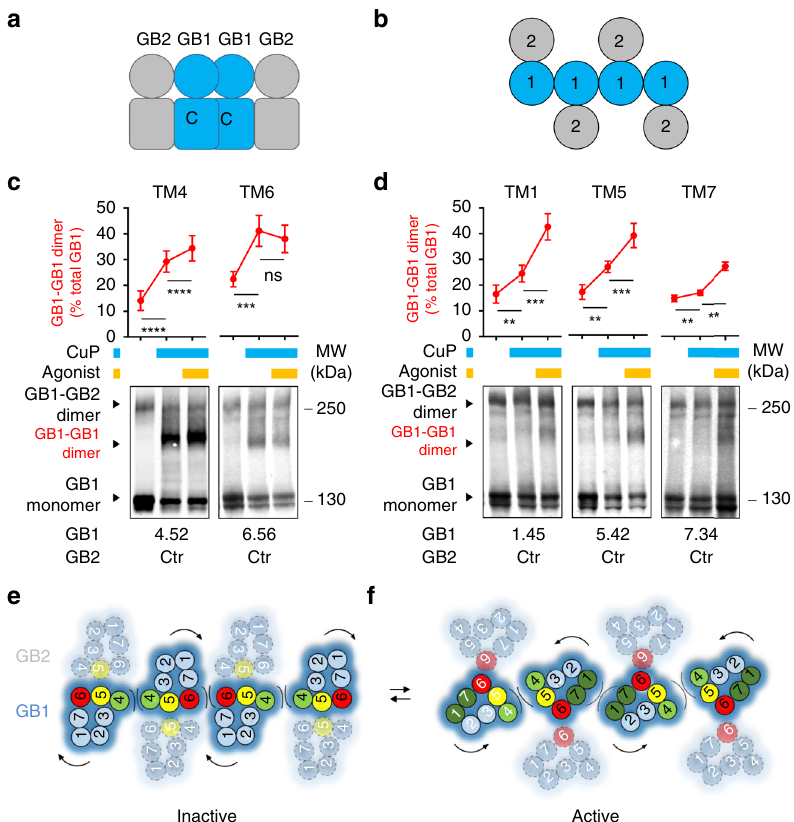
Fig. 6 Interactions between GB1 7TMs in GABA B oligomers during activation. a , b Schematic representation of a GABA B oligomer in lateral ( a ) and top view ( b ). c , d Blots showing cross-linking of cell surface SNAP-GB1 subunits containing a single cysteine substitution in TM1, TM4, TM5, TM6 or TM7, with GB2 Ctr after pre-incubation or not with GABA (agonist) and with CuP, as indicated. The percentage of GB1-GB1 homodimers (in red) relative to the total amount of GB1 subunit was quanti fi ed from the fl uorescent images. Data are mean ± SD from three independent experiments. Paired t test with Welch ’ s correction with **** P < 0.0001, *** P < 0.001 and ** P < 0.01, or not signi fi cant (ns). e , f Model for the structural organization of the GABA B 7TMs in higher- order oligomers in the inactive and active state. Interfaces at the GB1 subunits are